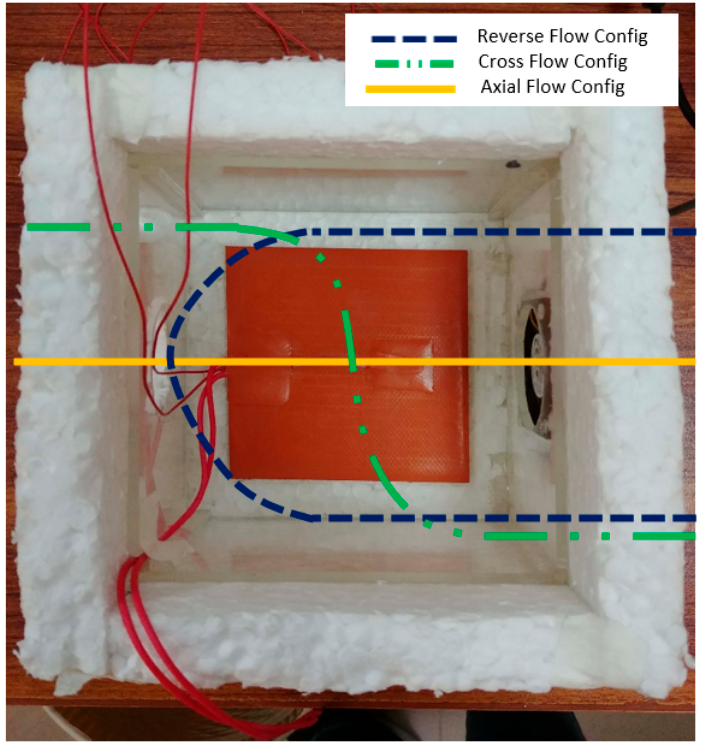
Figure 4. Axial flow, cross flow, and reverse flow configuration.